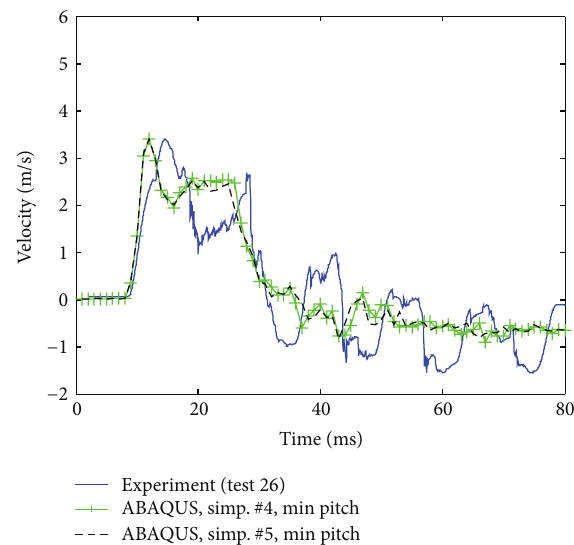
Figure 18: Velocity results for dynamic tension test, simplified model #4-5.